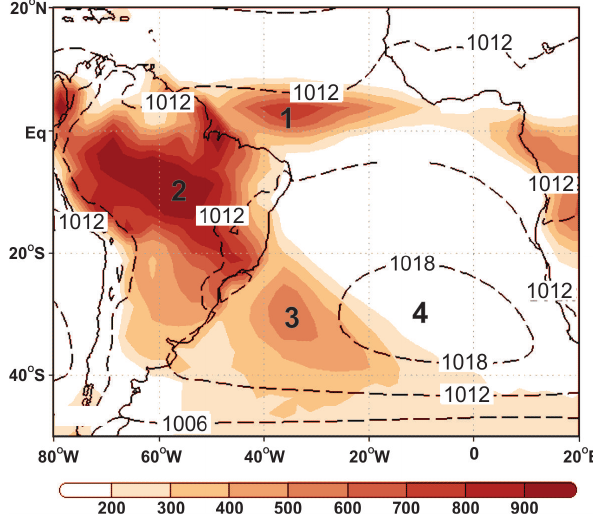
Fig. 1. Atmospheric mean circulation (1979–2010) at the surface level during austral summer (December to February), derived from ERA-Interim dataset (Dee et al., 2011). (1) Intertropical Conver- gence Zone (ITCZ); (2) and (3) South Atlantic Convergence Zone (SACZ), continental and oceanic components, respectively; (4) South Atlantic Subtropical High. Colours refer to mean precipita- tion during the December-January-February period, in millimetres (mm); dashed black lines refer to mean sea level pressure, in hec- topascals (hPa). Vertical axis refers to latitude values, and horizontal axis refers to longitude